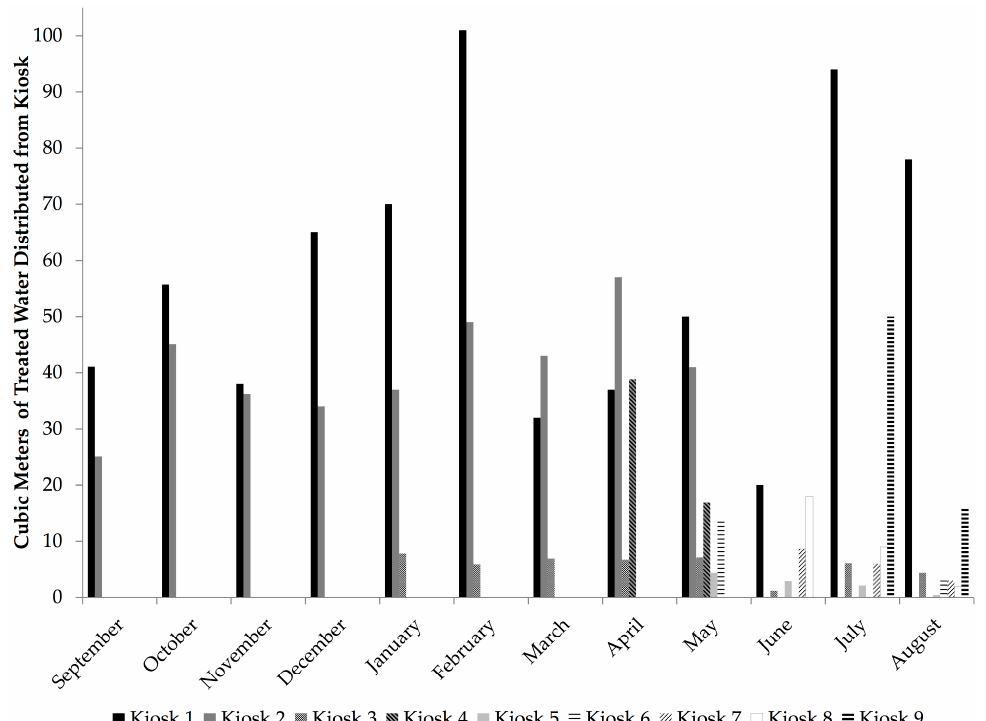
Figure 1. Volume of Water Distributed from Kiosk per Month at Nine Water Kiosks at Health Care Facilities in Rural Rwanda, 2013–2014. Table 3. Month Averages per Kiosk for Revenue, Profit Margin, Volume of Water Distributed, Production Cost, Water Loss and Measures of Correlation, for Nine Water Kiosks at Health Care Facilities in Rural Rwanda,